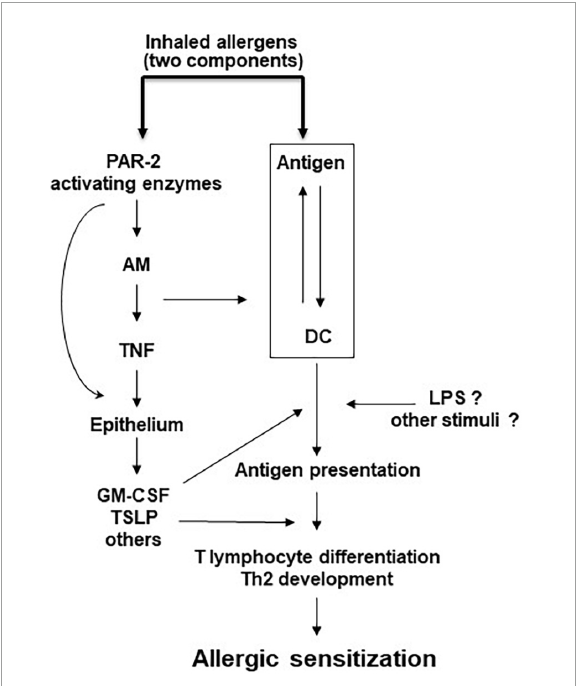
FIGURE2 Model of PAR-2-mediated allergic sensitization. Allergic sensitization requires the recognition of an antigen by DC and also PAR-2 activation by an allergen with serine protease activity, or by an independent serine protease. Other stimuli may facilitate this process. AM, alveolar macrophages; DC, dendritic cells; GM-CSF, granulocyte macrophage colony stimulating factor; LPS, lipopolysaccharide; TNF, tumor necrosis factor; TSLP, thymic stromal